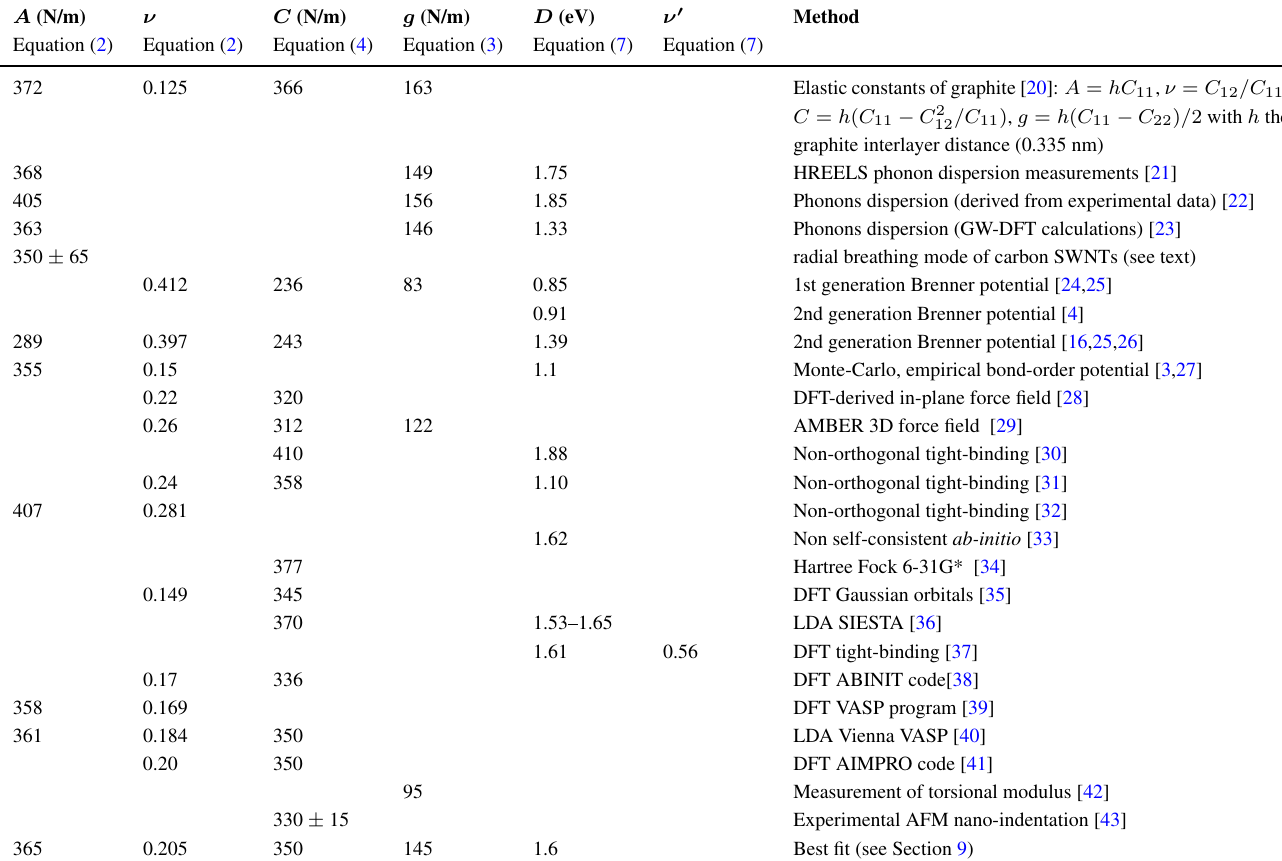
Table 1. Elastic constants of graphene obtained by various methods. Each line of the table lists parameters obtained by independent measurements or calculations.